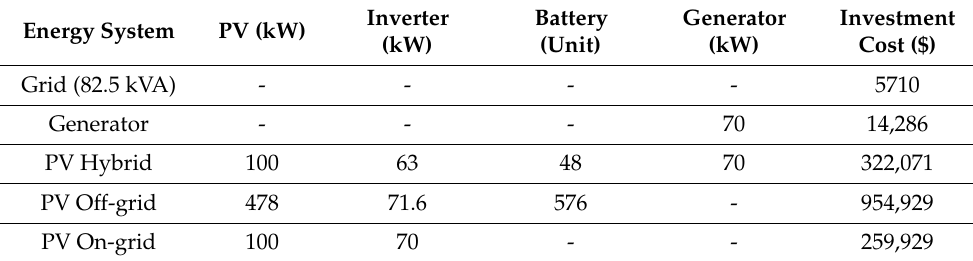
Table 4. Equipment Sizing and Investment Cost of Energy